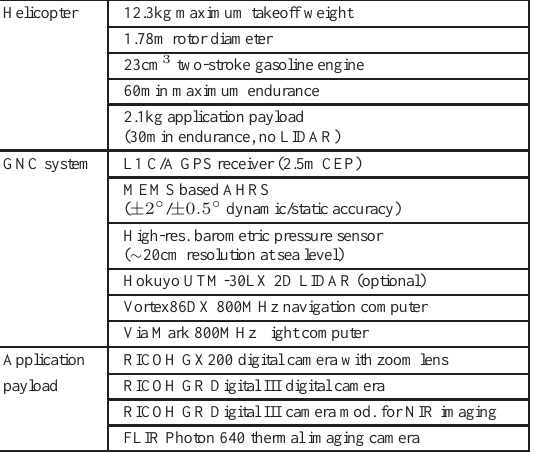
Table 1: Technical specifications of key system components. tion system kills the engine and commands full collective pitch in case of RC link loss, low voltage, or miscellaneous fatal er- rors. For BVR flights, a loss of the RC link is ignored as long as the heartbeat signal is active. The flight termination is activated when the heartbeat is inactive and the RC link is lost or in case of low voltage or fatal errors. In addition, it can be activated by the flight